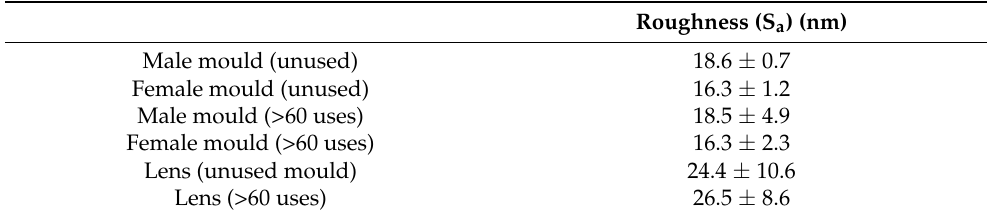
Table 1. White light interferometry surface roughness values of COC moulds before and after UV light exposure and two different soft contact lenses.